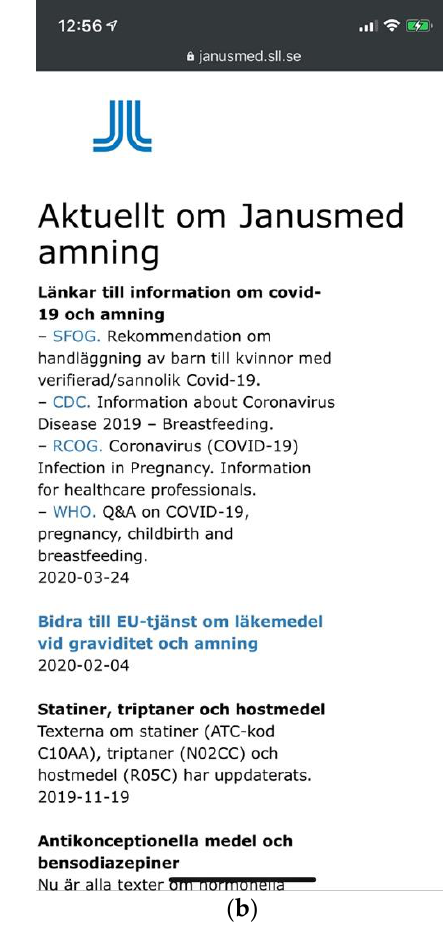
Figure 11. ( a ) Visual and typographic hierarchies at Janusmed are broken across sections of the page; ( b ) Current news for the breastfeeding section opens in a new tab without means of navigation.